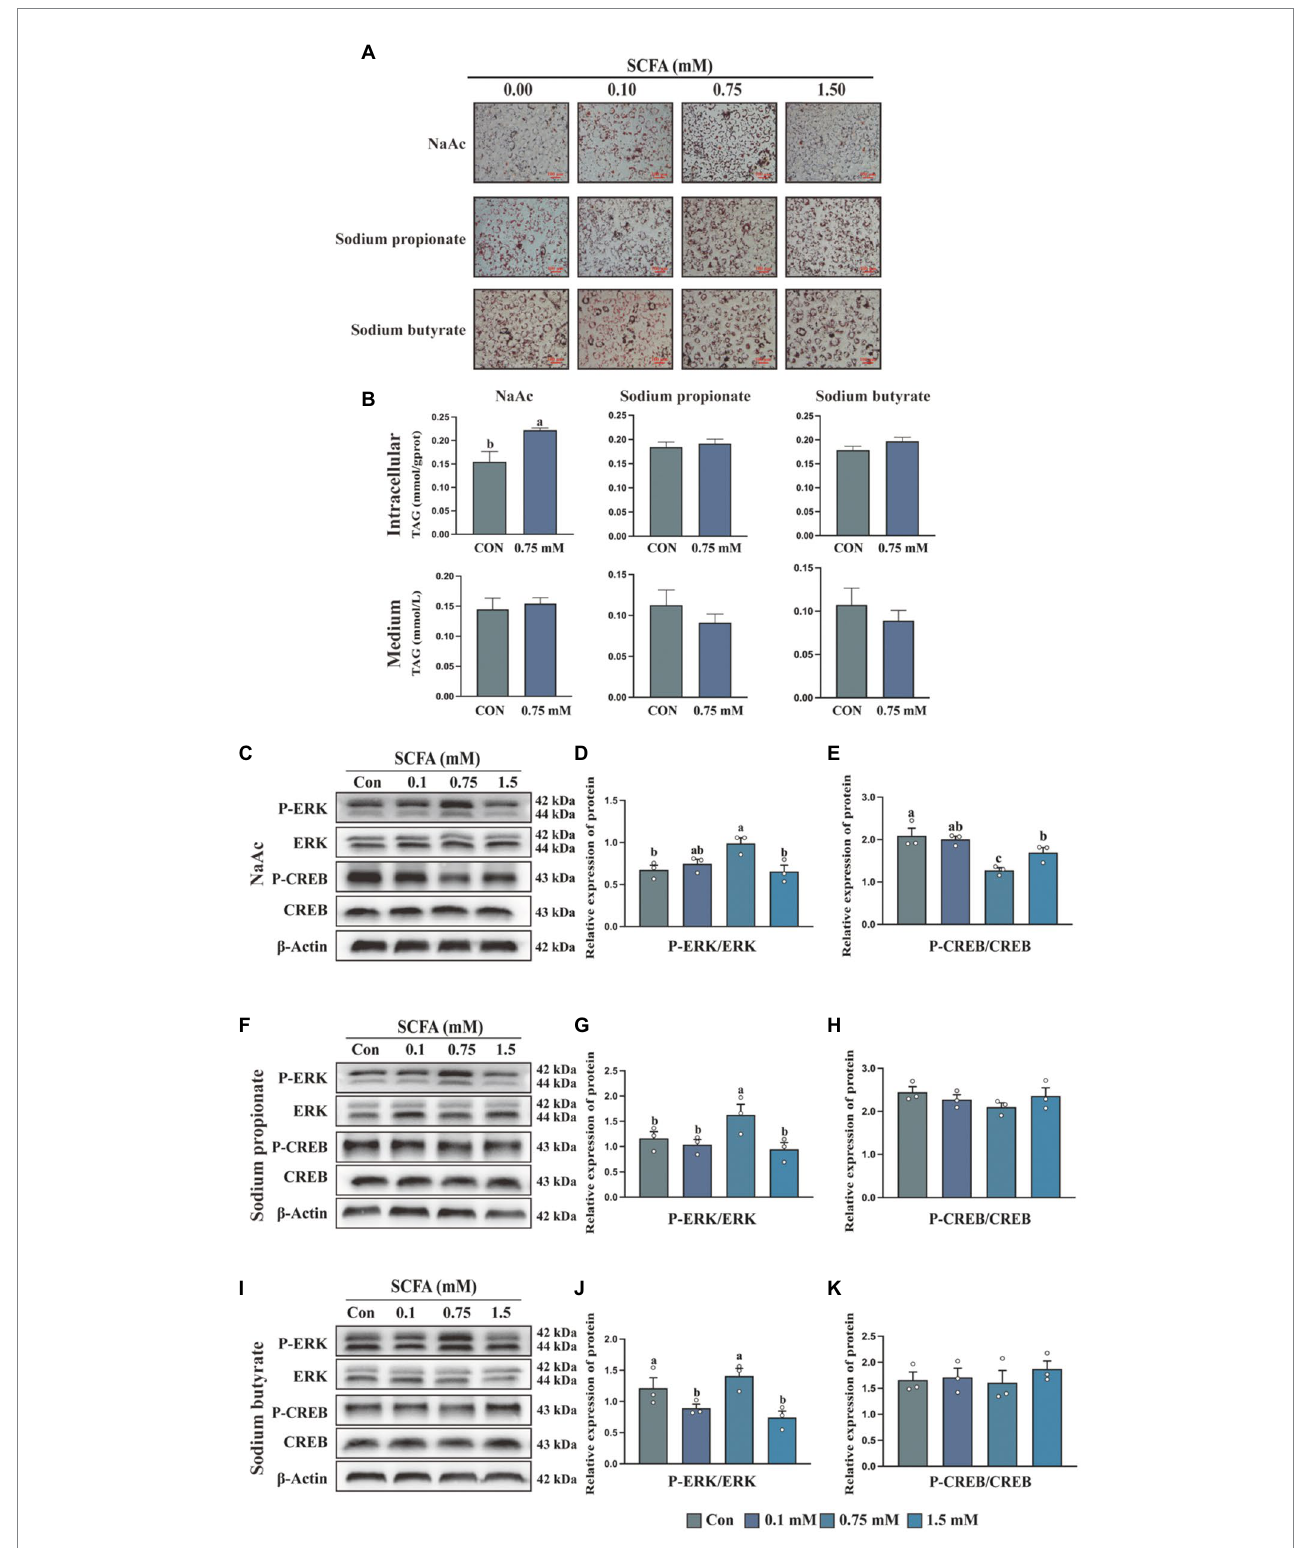
FIGURE 1 Short-chain fatty acids (SCFA) regulate milk fat synthesis in HC11 cells through the G pathway (A) Oil red O staining images of HC11 cells treated with α i different concentrations of sodium acetate (NaAc), sodium propionate and sodium butyrate. Scale bars are 100 μ m. (B) TAG content in intracellular and medium. The relative protein expression level of P-ERK/ERK and P-CREB/CREB were treated with different concentrations of NaAc (C–E) , sodium propionate (F–H) , and sodium butyrate (I–K) . All data with error bars are averages ± SEM ( n = 3). In histograms, no letter or the same letter above the bar graph indicates no significant difference ( p > 0.05), and different letters indicate a significant difference ( p < 0.05). Each small white dot represents a test